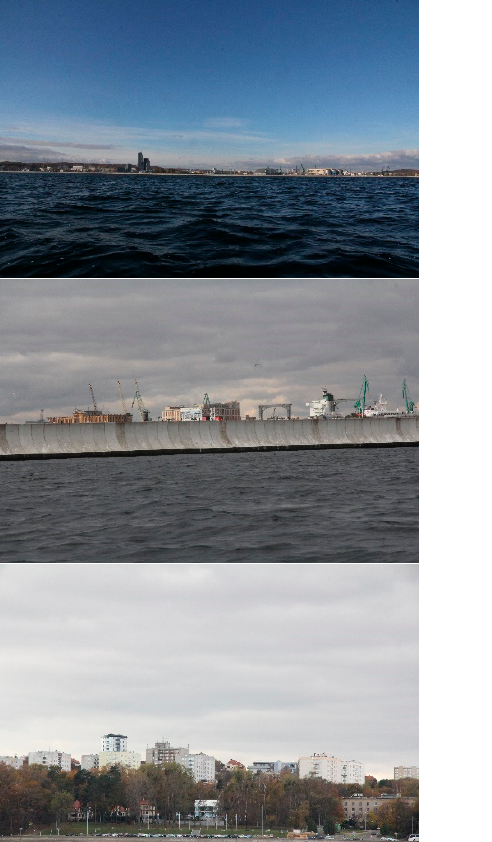
Figure 16. Results of the Flood Fill algorithm.